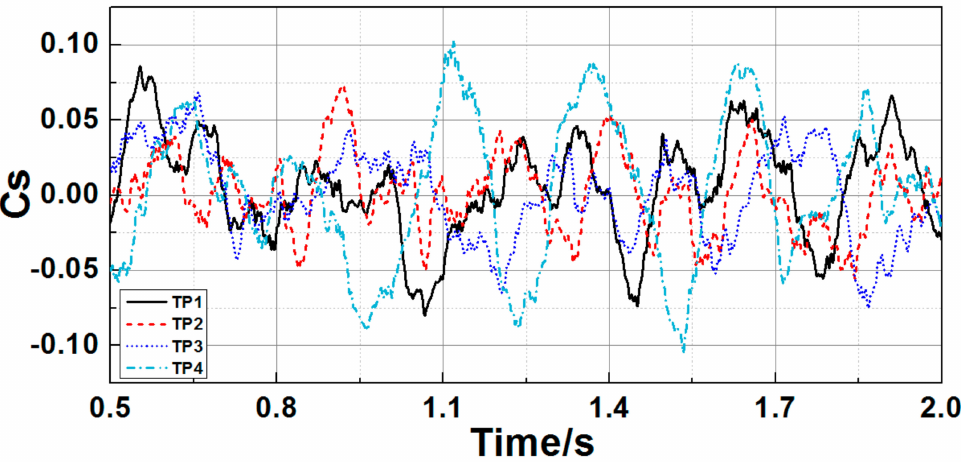
Figure 16. Time histories of coefficients of the side force (Cs) for the four